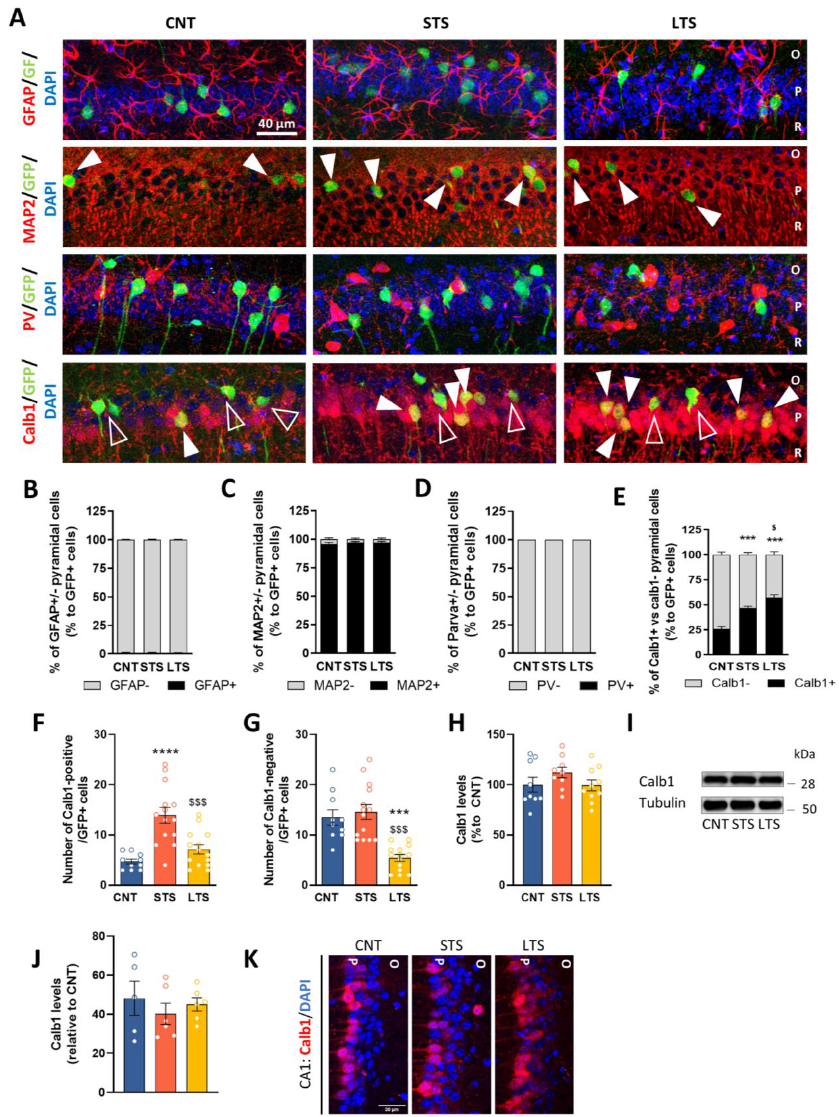
Figure 3. Neural identity characterization of Egr1-dependent activated cells by short- or long-term stress in the CA1. ( A ), Representative images showing the identity of the activated cells (green) by co-labeling with specific cells markers (red). In all rows, GFP-positive cells are in green. First row: representative images from all conditions (CNT, STS and LTS) showing labeling of astrocytes (red). Second row: labeling of MAP2 (red). White arrows point to GFP- and MAP2-double-positive neurons. Third row: labeling of parvalbumin (PV, red). Fourth row: labeling of calbindin1 (Calb1, red). White arrows point to double-positive GFP- and calbindin-double-positive neurons. Open arrows point to GFP-positive calbindin-negative cells. ( B – E ), Quantification of the percentages of double-positive cells in CA1 for GFP and GFAP ( B ), GFP and MAP2 ( C ), GFP and PV ( D ), and GFP and Calb1 ( E ). Values are means ± SEM, N = 7 mice per group. In ( E ), statistical analysis with one-way ANOVA, group effect: F (2,18) = 42.31, p < 0.0001. Total number of GFP-positive cells per surface unit that are also calbindin1-positive ( F ) or calbindin-negative ( G ). Statistical analysis with one way ANOVA, in ( F ), F (2,35) = 15.91, p < 0.0001 and in ( G ), F (2,35) = 17.40, p < 0.0001. Densitometry quantification ( H ) and representative immunoblots ( I ) of calbindin levels in the hippocampal lysates of CNT, STS and LTS mice. N = 9–10 mice per group. Quantification of calbindin intensity in the CA1 ( J ) and representative images ( K ) of CNT, STS and LTS mice, N= 5–6 mice per group. All values are expressed as means ± SEM. Tukey’s post hoc test, **** p < 0.0001 or *** p < 0.001 compared to CNT and $ < 0.05, $$$ p < 0.001 compared to STS mice. O, Stratum oriens; R, Stratum radiatum; P, Stratum